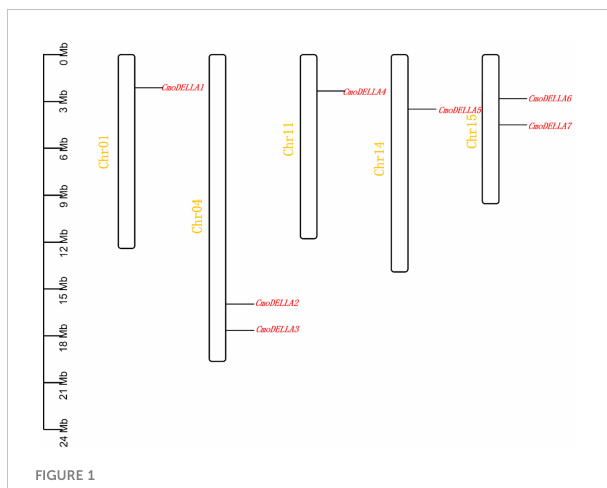
FIGURE 1 Chromosomal localization of CmoDELLA genes. The names of seven CmoDELLA genes are shown to the right of each chromosome. Gene position can be measured using the scale on the left of the fi gure in megabases